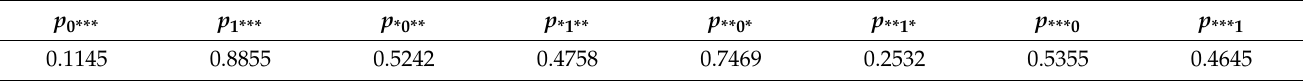
Table 5. Single-factor change probability of marine